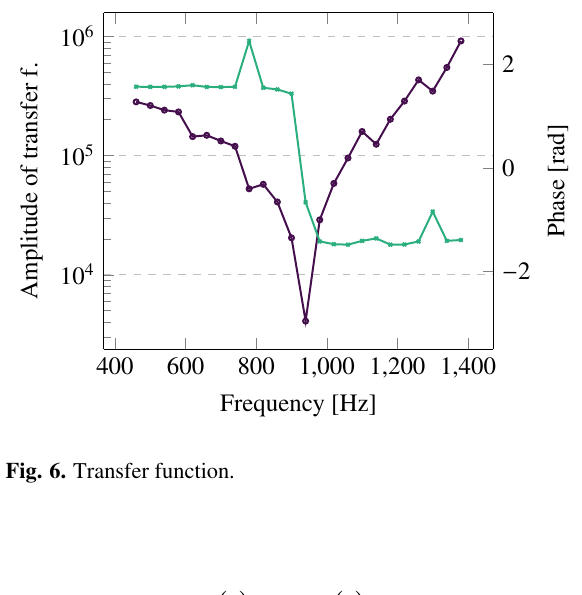
Fig. 6. Transfer function